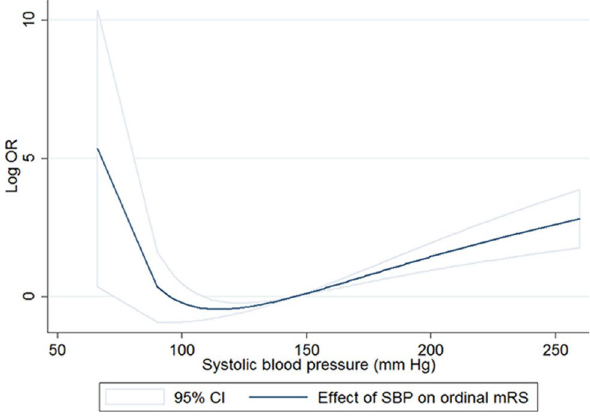
Fig. 3 Relation of SBP with functional outcome (modified Rankin Scale [mRS] score after 90 days) in the total Multicenter Randomized Clinical Trial of Endovascular Treatment of Acute Ischemic Stroke in the Netherlands (MR CLEAN) population. CI indicates confidence interval. (From Mulder MJHL, Ergezen S, Lingsma HF, et al. Stroke. 2017;48:1869–1876 with per- mission from publisher,